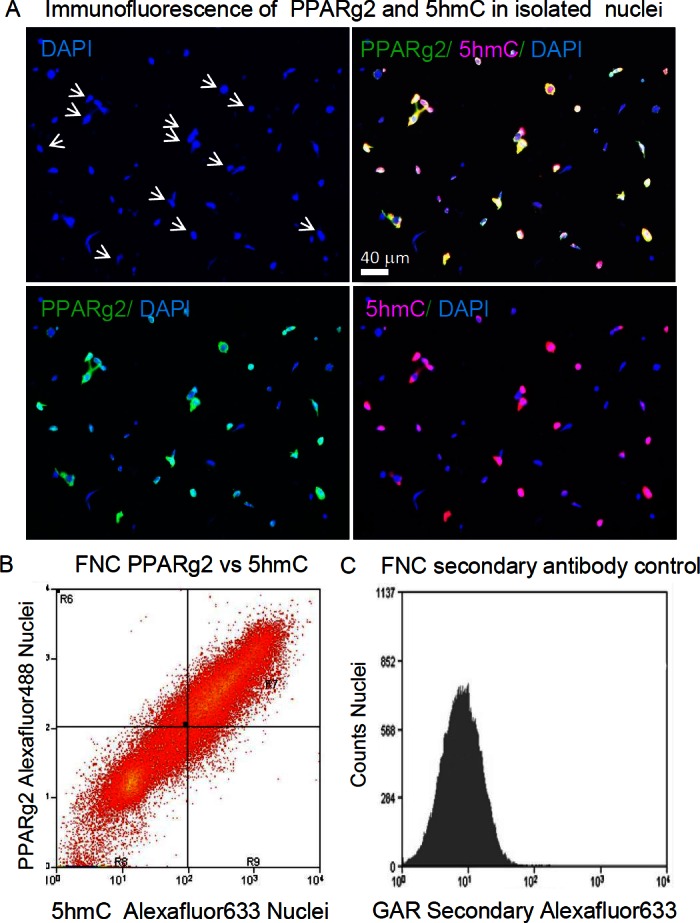
Distribution of 5hmC among adipose tissue nuclei.IFM and FNC were used to examine 5hmC levels among visceral adipose tissue nuclei. A. A field of VAT nuclei examined with various combinations of DAPI staining for DNA, and immunostaining with mouse anti-PPARg2 + goat anti-mouse Alexafluor488 and rabbit anti-5hmC + goat anti-rabbit Alexafluor633. White arrows indicate those large, decondensed nuclei that are stained strongly for both 5hmC and PPARg2. B. Flow Cytometry of VAT nuclei immunostained as in A. C. Goat anti-rabbit secondary antibody used in B shows only modest background staining of nuclei. Nuclei were gated for DAPI (>2C DNA content) and size and shape by light scattering as in S1 Fig. For antibodies see S1 Table.